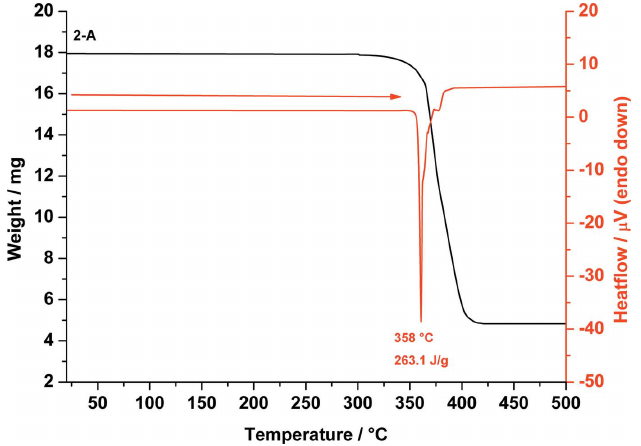
Figure 6 Combined DSC (red) and TGA (black) traces of scyllo -inositol ( 2 -A) measured from 20 to 500 (cid:2) C showing the decomposition of 2 -A at 358 (cid:2)